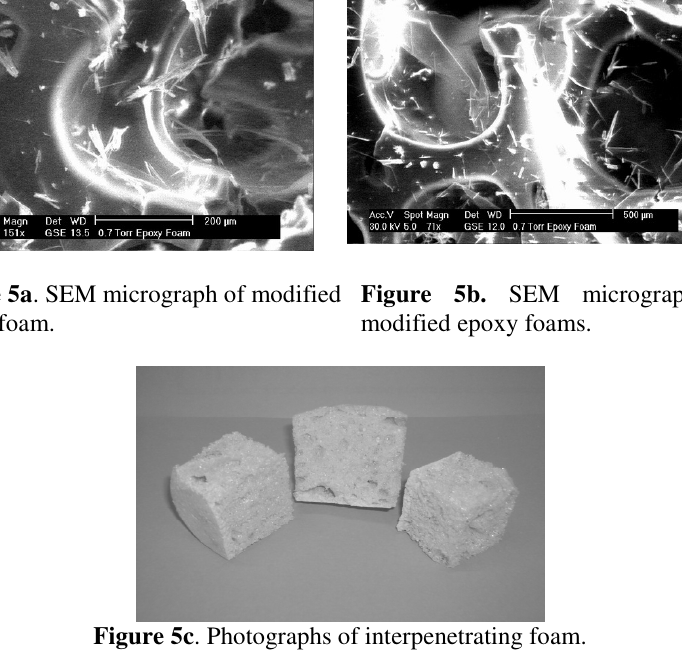
Figure 5c . Photographs of interpenetrating